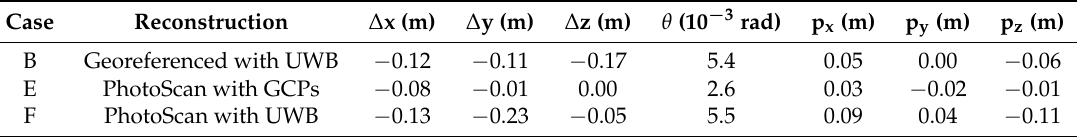
Table 3. Bias in